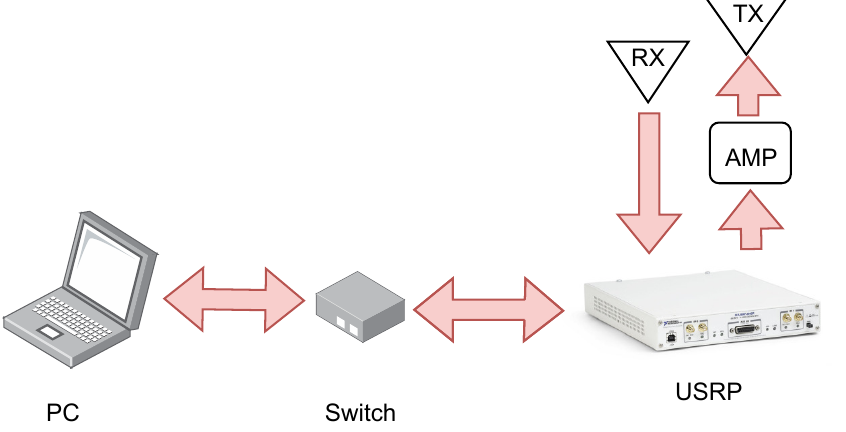
Figure 7. Flow diagram to differentiate the types of tag